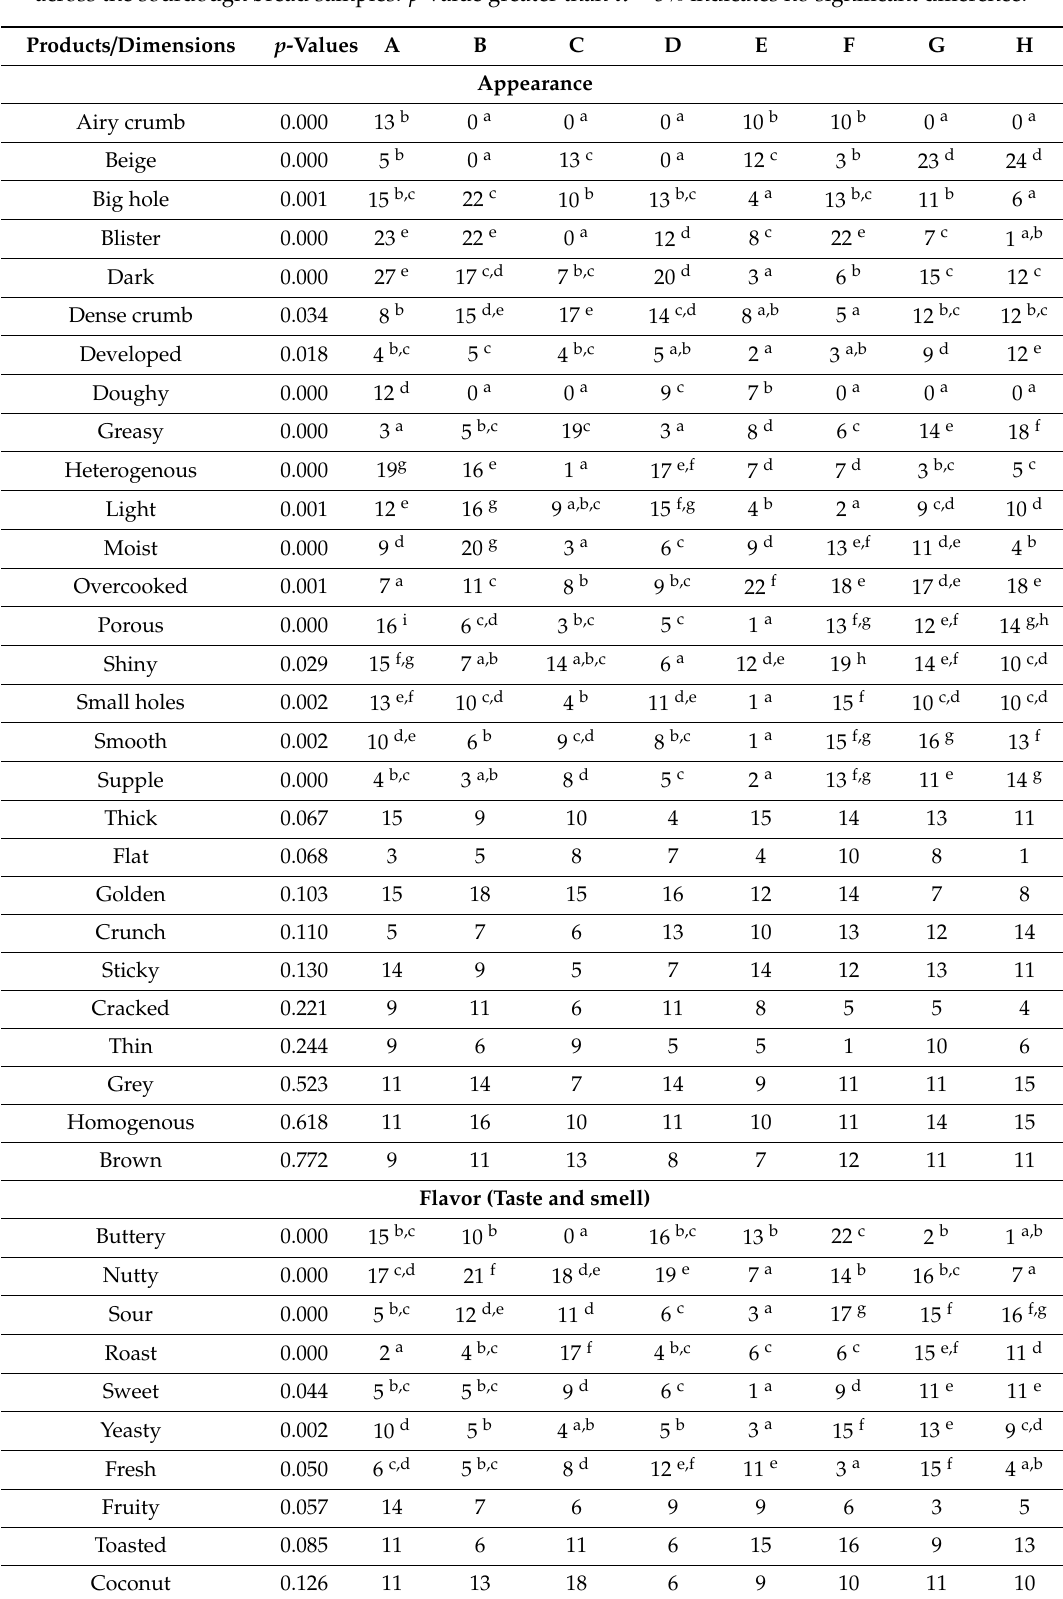
Table 3. CATA data by citation frequency and Cochran’s Q test associated with each sample of CWK a–i : Di ff erent superscript letters in rows denote frequencies of attributes that are significantly di ff erent across the sourdough bread samples. p -value greater than α = 5% indicates no significant di ff